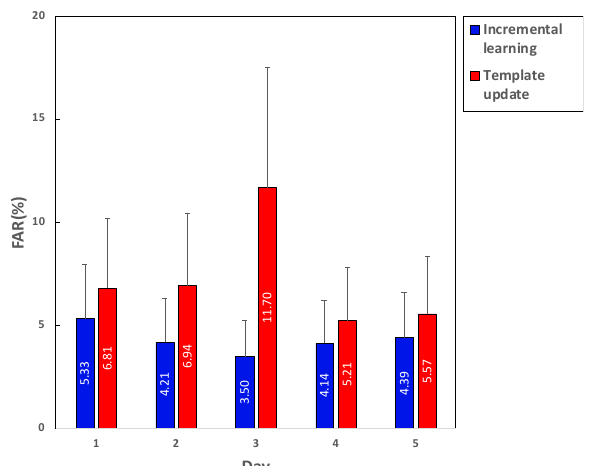
Figure 14. The result of the benchmark test with the incremental learning and template update in terms of FAR.